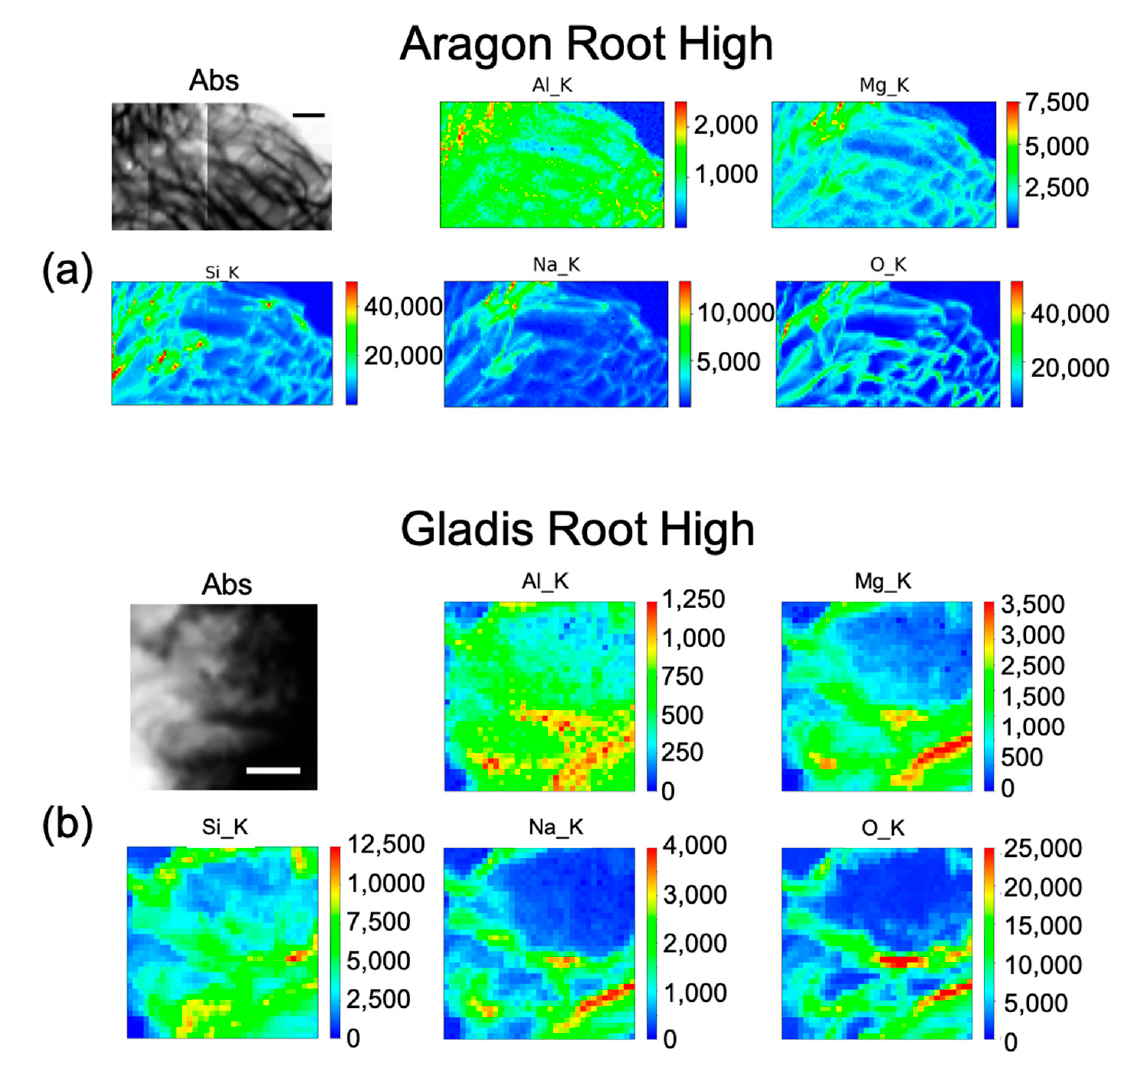
Figure 5. Micro-X-ray Fluorescence ( µ -XRF) elemental maps of O, Al, Na, Mg, and Si, depicting the distribution within the cells in ( a ) Aragon Root High Si treatment, and of ( b ) Gladis Root High Si treatment, shown with their corresponding absorption image (Abs). Scale bar is 10 µm.